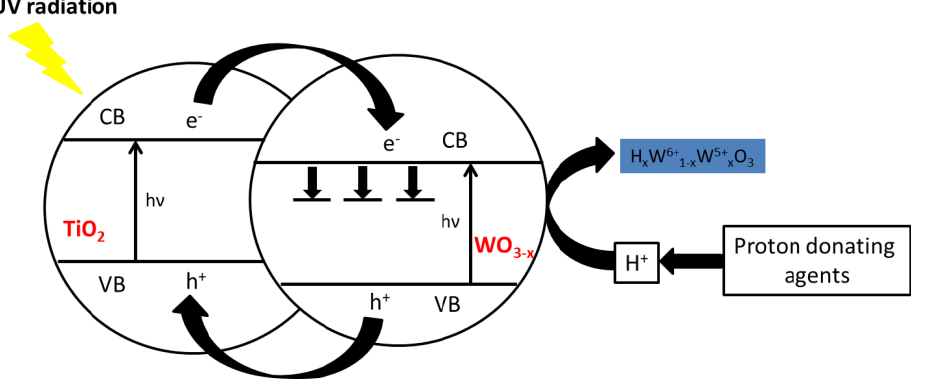
Figure 6. Scheme of photochromism mechanism in WO 3-x :TiO 2 systems.